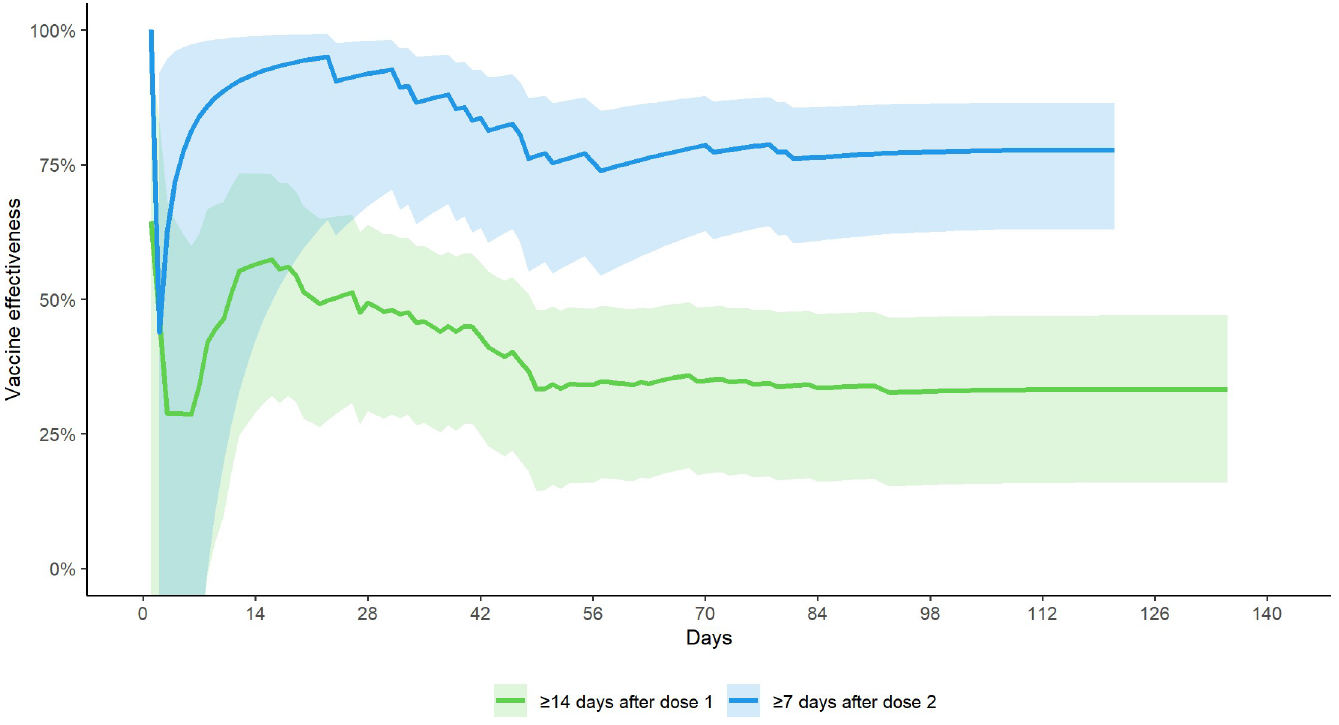
Fig 4. Vaccine effectiveness (mRNA vaccine) comparing one dose and two doses over